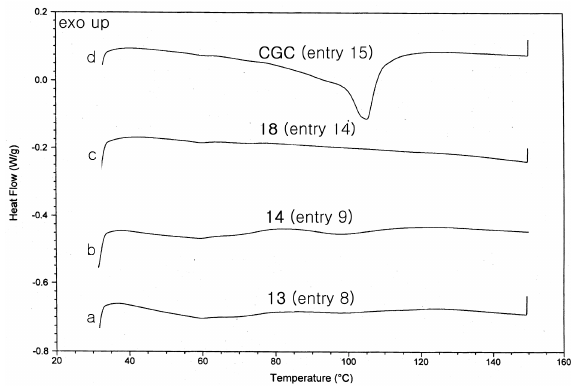
Figure 3. Differential scanning calorimeter (DSC) curves of the generated polymers.